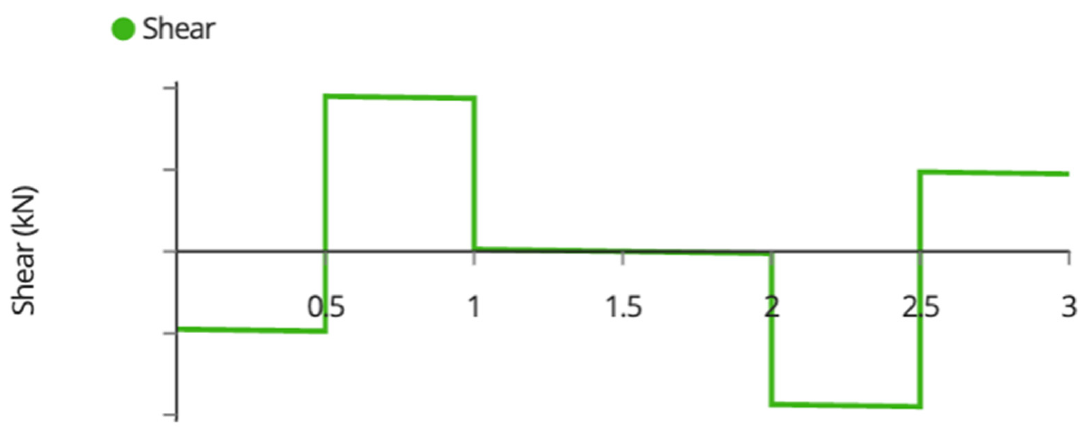
Figure A6. Beam Shear Force Diagram.